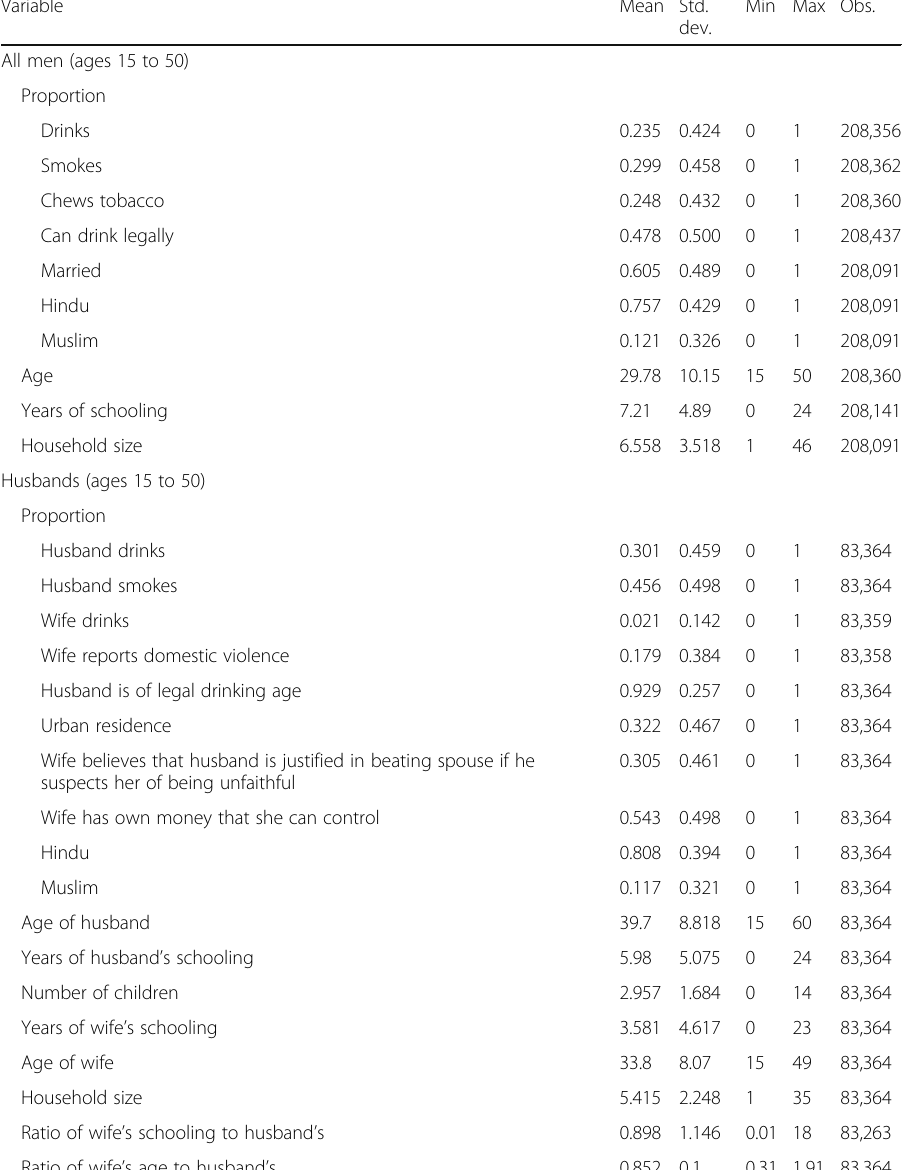
Table 1 Summary statistics of key variables in the NFHS Variable Mean Std.